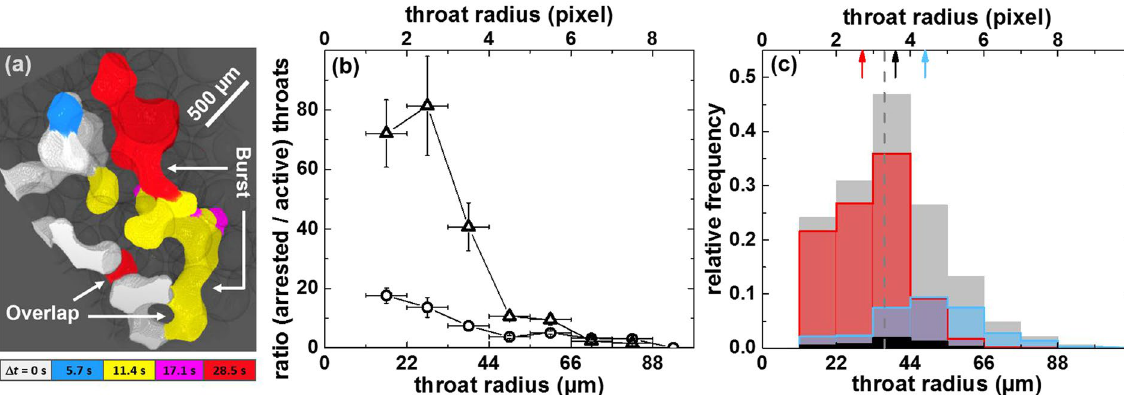
Figure 2. Pore-filling events and throat size analysis during water injection. ( a ) Three-dimensional volume rendering of five time steps during fluid invasion into glass beads (semi–transparent), θ ≈ 125°. These images were recorded with a time interval of 5.7 s using the on-board memory of the camera. The aqueous phase was injected at an average front velocity of 3 μ m/s. The progressing fluid front is shown in white, blue, yellow, magenta and red. ( b , c ): Analysis of the large scale experiments shown in Fig. 1 recorded with a time interval of 250 s. Throats and menisci determining the position of the fluid front are identified in a first time step. The fraction of those menisci and throats which still determine the position of the fluid front in a consecutive time step are called ‘arrested throats’ while the fraction of those throats which got filled are termed ‘active throats’. Data are averaged for ten consecutive time steps when the invasion front was already fully developed but not yet exceeded the imaged volume (0.1  PV  0.5). ( b ) Fraction of ‘arrested throats’ divided by ‘active throats’ as a function of throat size for glass (triangles) and basalt beads (circles) ( θ ≈ 75°). The errors in x - and y -direction denote the bin size and the mean value, respectively. ( c ) Histograms of arrested throats (red), active throats (black), and throats that became filled within the respective time interval and which were not present at the fluid front neither in the first nor in the second time step (blue), normalized by the total number of throats at the fluid front. The throat size distribution of the entire bead pack (gray) is shown at a different scale for better visibility. The corresponding mean values of the distributions are indicated by arrows, and, for the entire bead pack, by the gray dashed